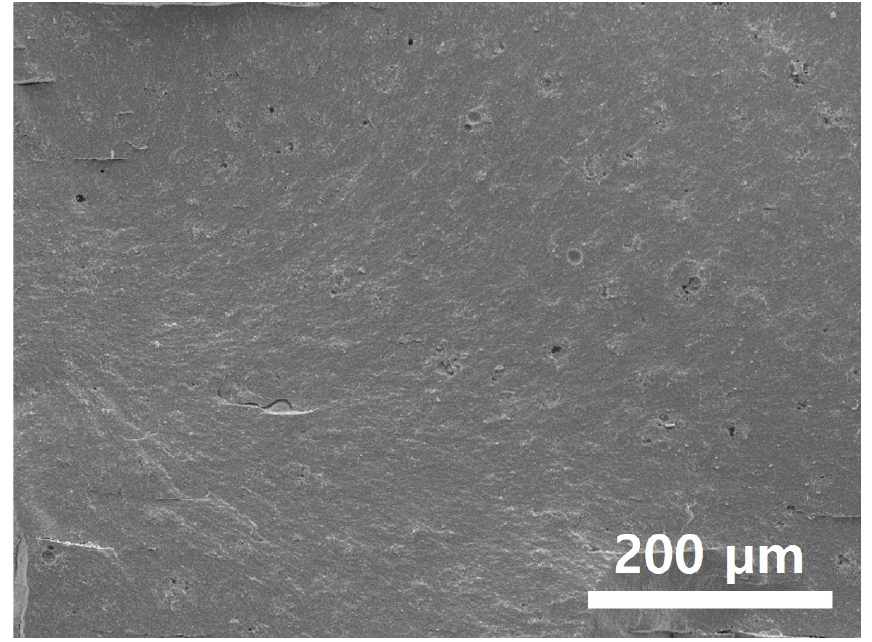
Figure 21. Cross-sectional SEM image of micro square pa tt ern after sintering.